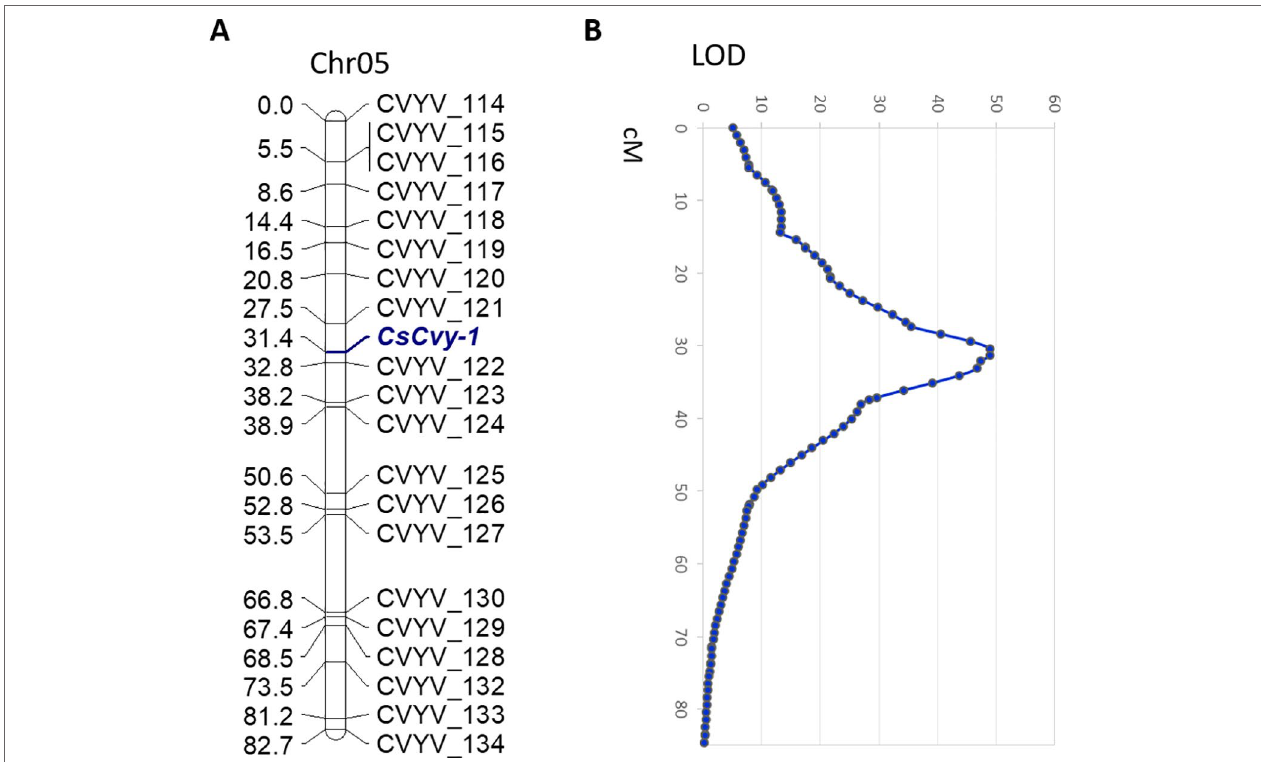
FIgURe 2 | (A) Genetic linkage of SNP markers and the resistance locus CsCvy-1 in Chr05. Genetic distance is expressed as centiMorgans (cM). The CsCvy-1 gene is flanked by two markers in an interval of 5.3 cM. (B) Major QTL detected on Chr05 corresponding to CsCvy-1 locus.